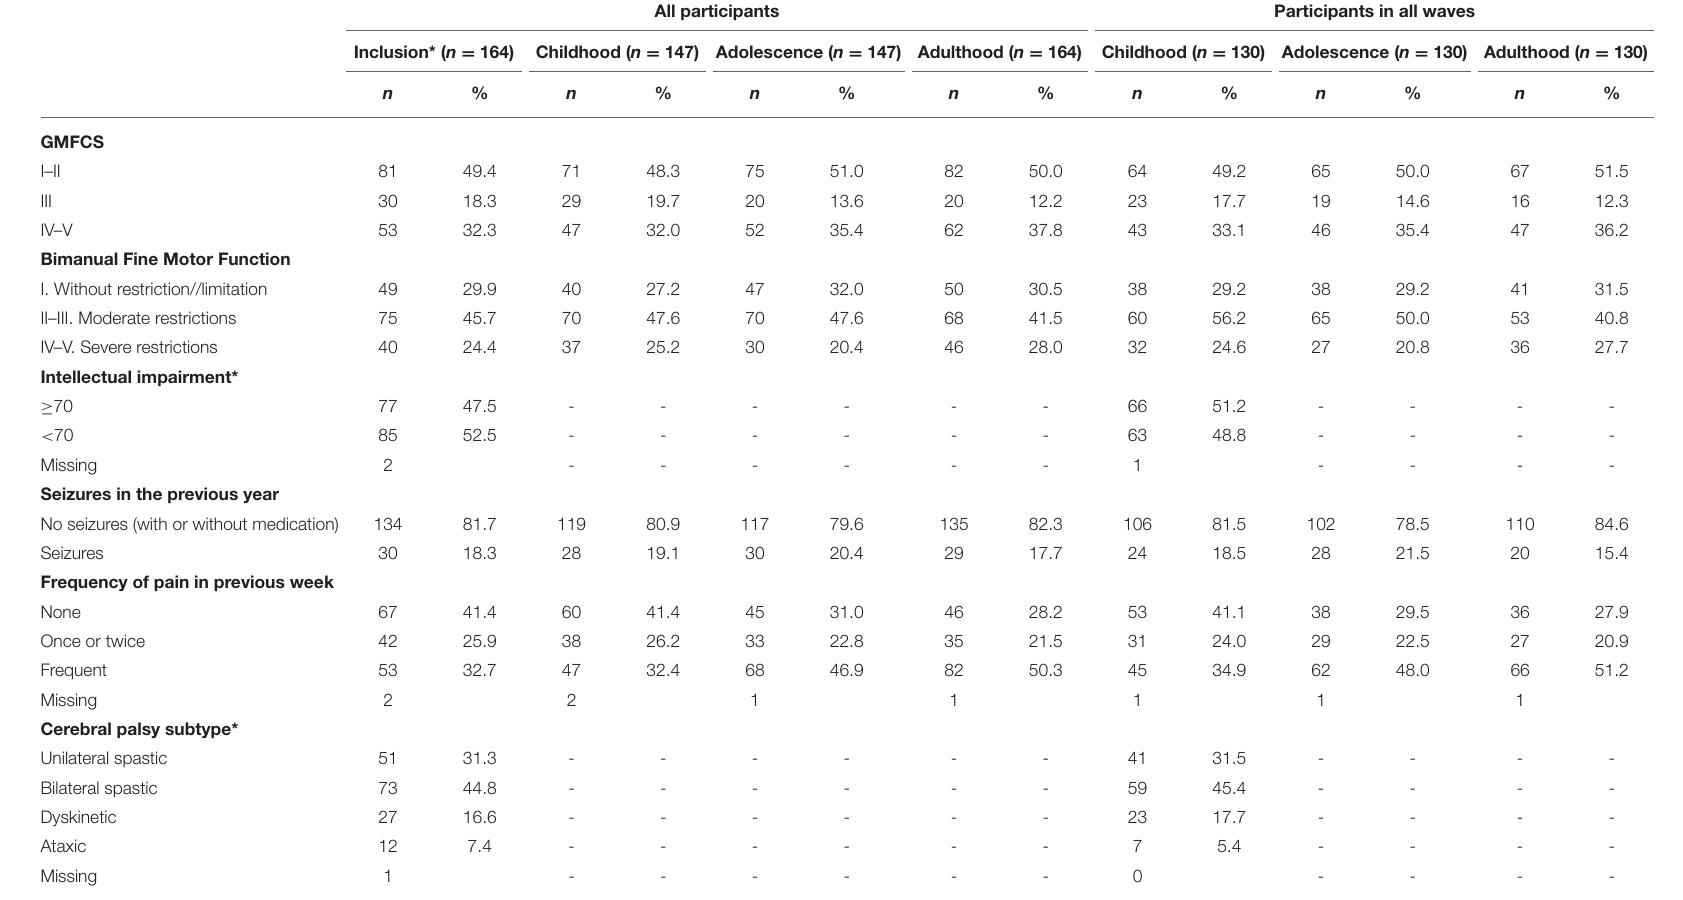
CP, cerebral palsy; GMFCS, Gross Motor Function Classification System. * Data provided at inclusion in the SPARCLE cohort in childhood (n = 147) or in adolescence (n =